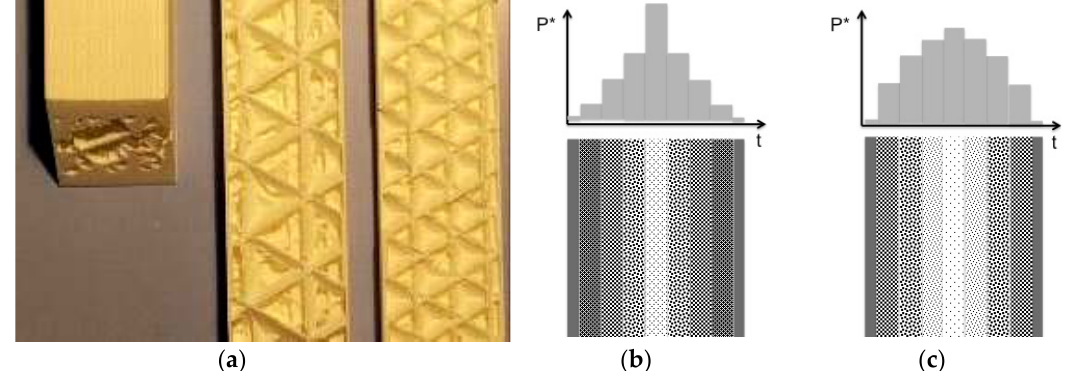
Figure 5. ( a ) Photograph of the convex porosity gradient specimen cross-section (left), triangular syntactic foam strut architecture in the center of the specimen (middle), and with progressively reducing pore size close to the edge of the specimen (right). The longitudinal section through the test specimens depicting the ( b ) convex and ( c ) concave porosity gradients investigated.